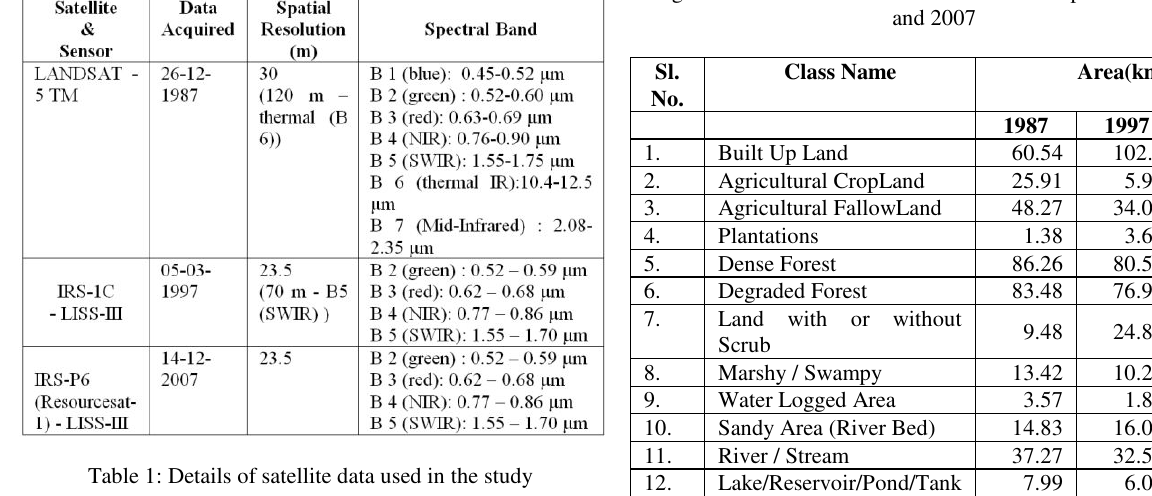
Figure 2. Classified Land Use Land Cover Map of 1987, 1997